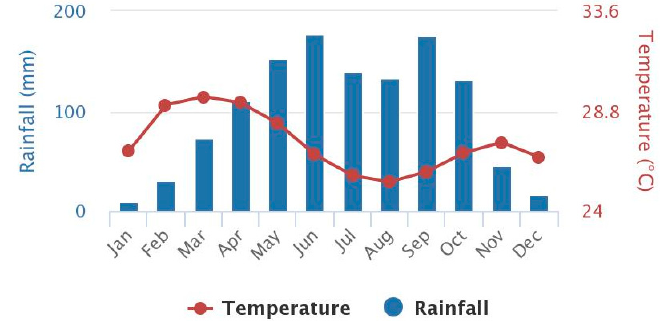
Figure 1. The Monthly trend of temperature and rainfall in Ghana.